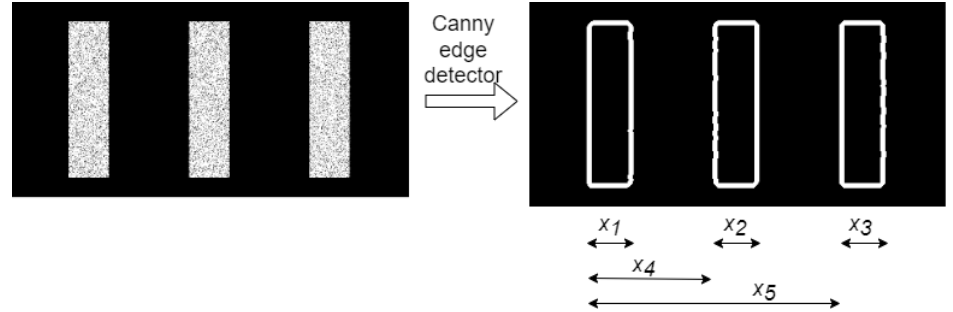
Figure 7. Image before and after applying Canny Edge